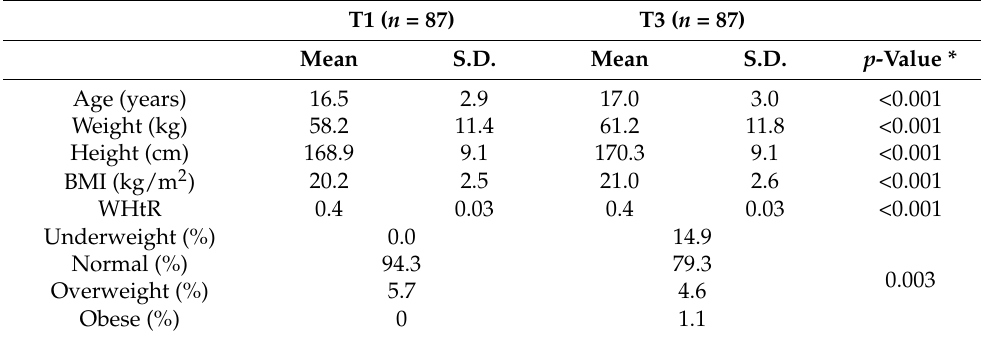
Table 1. Anthropometric characteristics of athletes at T1 and T3.